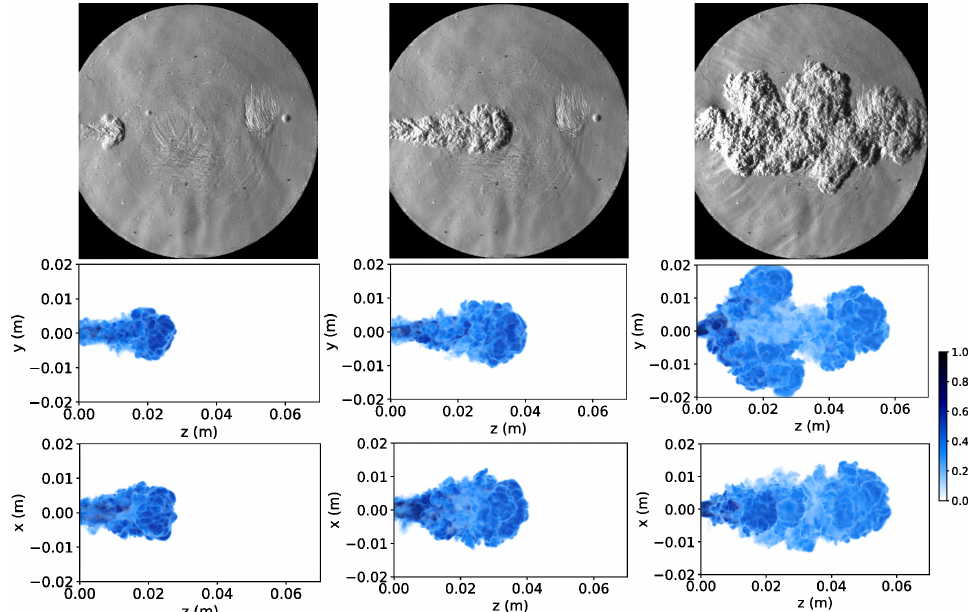
Figure 9. H 2 mass fraction Y s as volumetric rendering, projected on the respective cross planes x = 0 (middle row) and y = 0 (bottom row) for t = 450µs, 850µs and 1750µs (from left to right). The respective Schlieren images, showing the x = 0 plane, are displayed in the top row and are scaled similarly to the simulation plots.